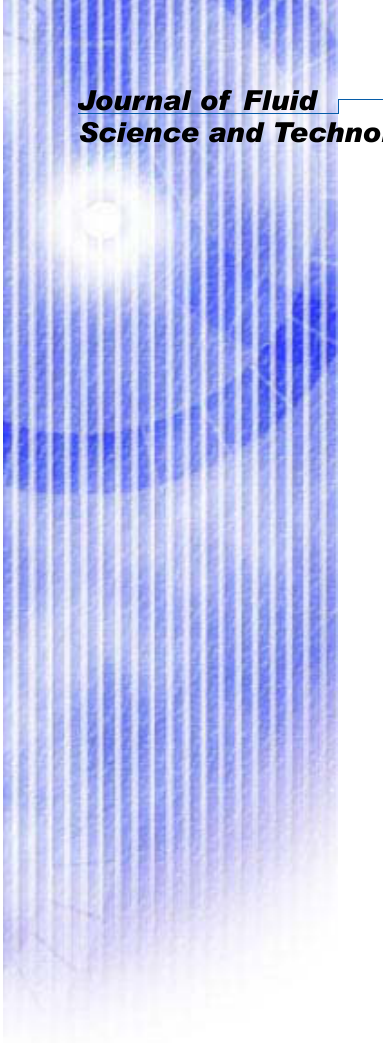
3 Velocity vector plot of secondary current in the cross